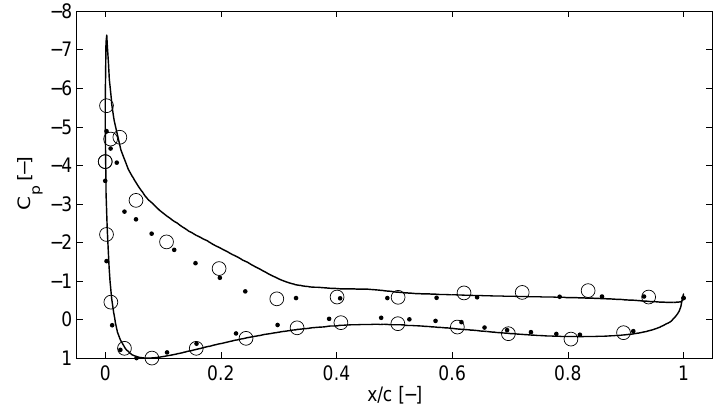
Figure 4. C distribution from r = 0 : 35 R for U 1 = 24 m/s, corresponding to AoA = 23 (cid:14) . p The dotted line represents 2D experimental results; the circles indicate 3D experimental results; and the full line shows 3D numerical results.